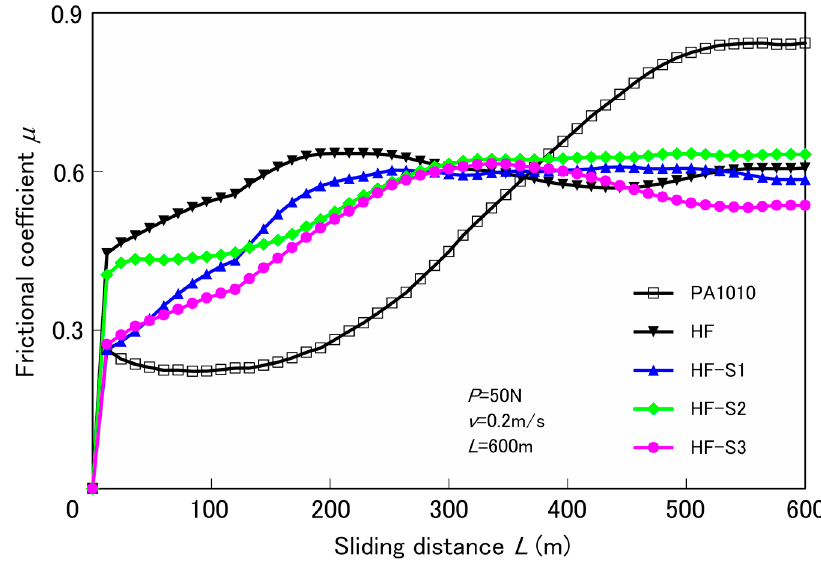
Figure 2. Frictional coefficient as a function of sliding distance for various surface-treated HF/PA1010 biomass composites.